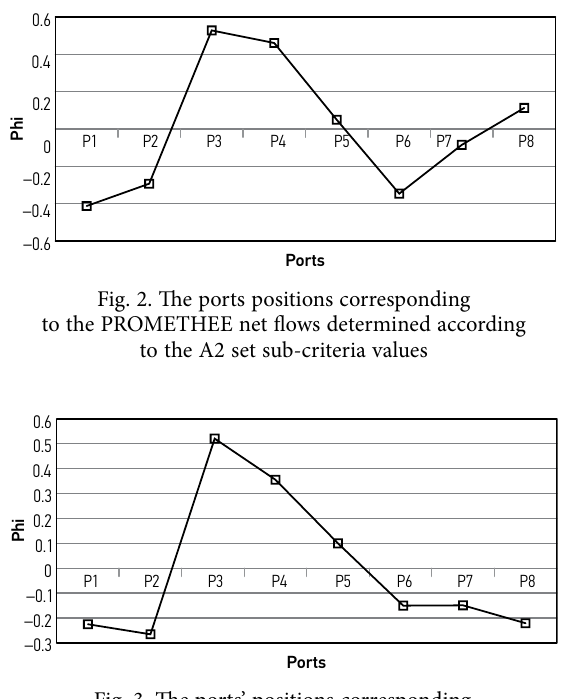
Fig. 3. The ports’ positions